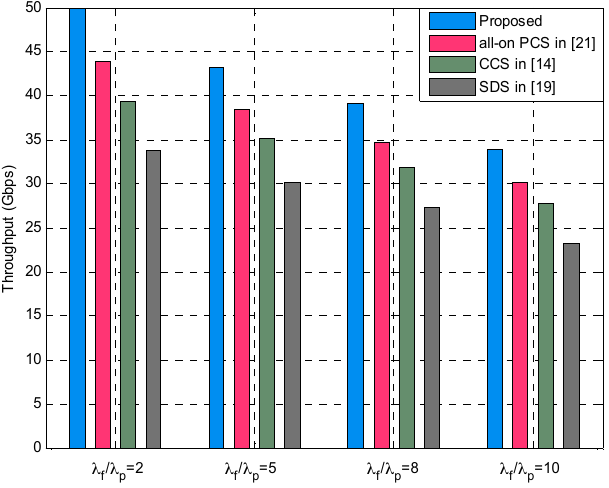
Figure 12. Overall throughput of small cells under different SBS density ratios when T p = 6.5 dB and T f = 0.5 dB.